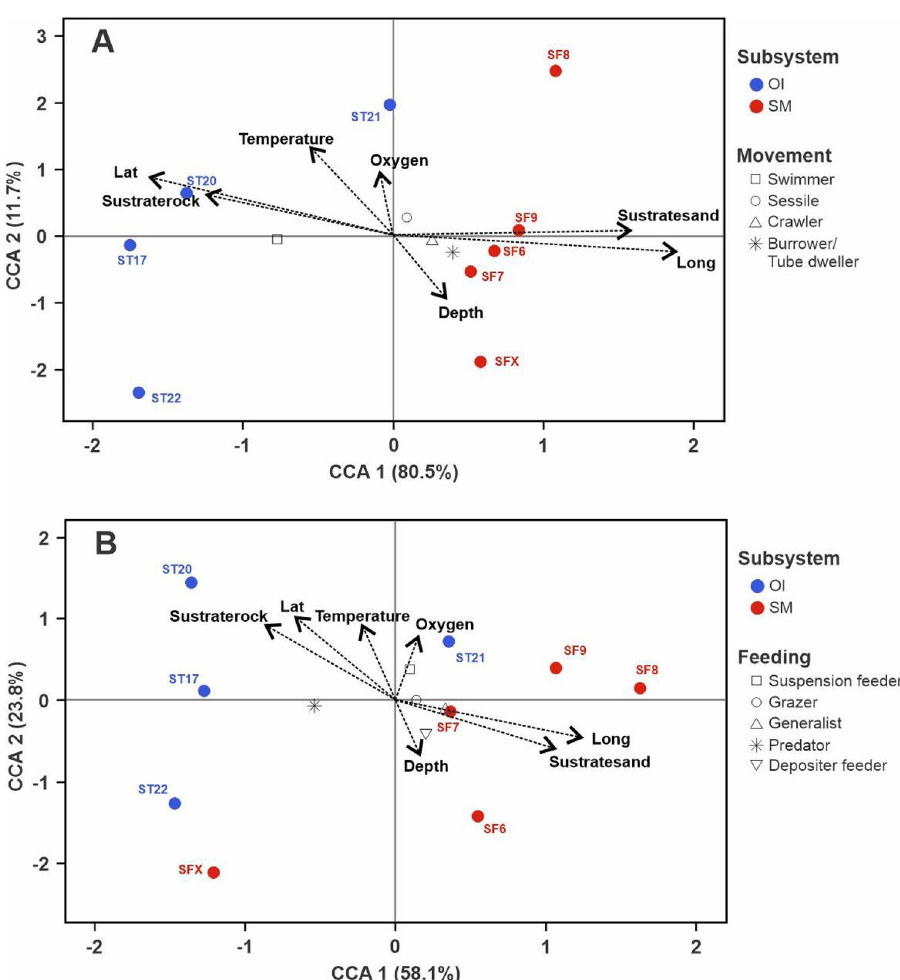
Figure 6. Canonical correspondence analyses (CCA) analysis based on the community structure of benthic megafauna grouped by movement type ( A ) and feeding mode ( B ) from stations sampled at Desventuradas Islands (OI, blue markers) and seamounts (SM, red markers) of the Nazca Desventuradas Marine Park. Vectors represent the contribution of environmental descriptors (oxygen, temperature, substrate type, depth, latitude and longitude). Image generated using R software (version 4.0.3) 47